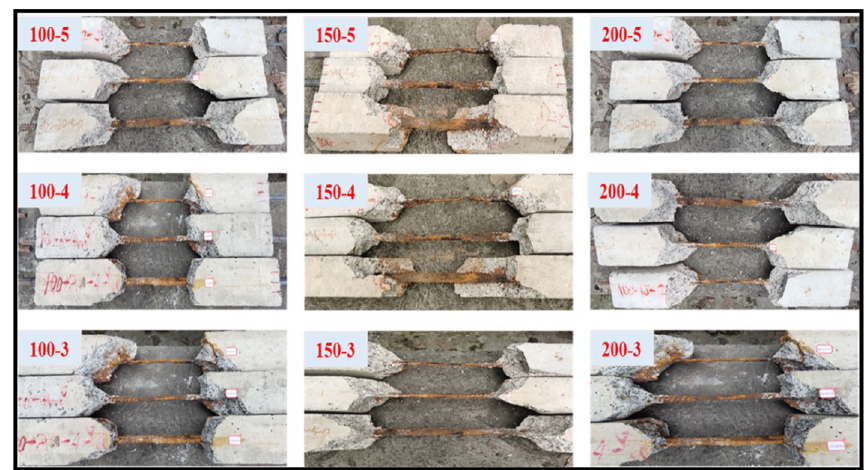
Fig. 7 Internal situation of steel bar corrosion of concrete structure specimen